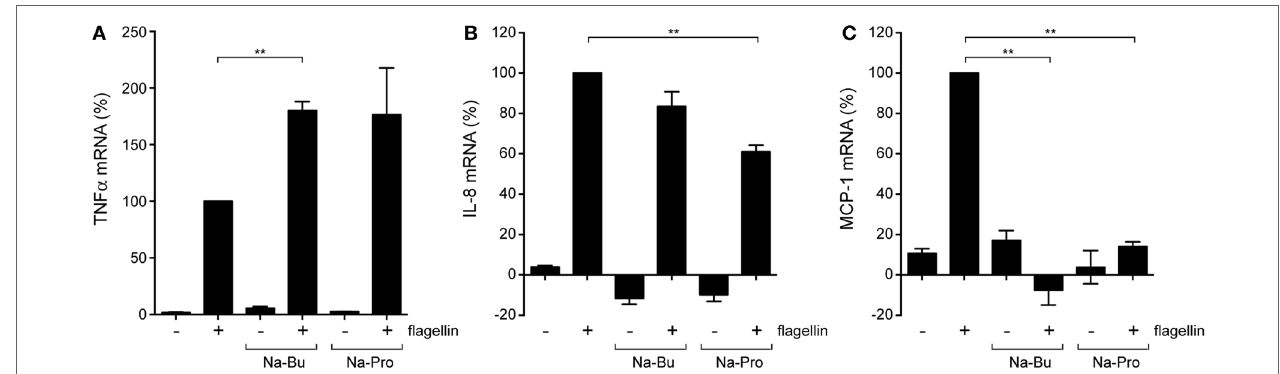
FigUre 3 | Modulation of cytokine expression by scFas. Quantitative RT-PCR of colonic epithelial HT-29 cells incubated with 10 mM Na-Butyrate or Na-Propionate for 30 min and stimulated with flagellin for 5 h. (a) mRNA levels of the pro-inflammatory cytokine TNF α . (B) mRNA levels of neutrophil chemotactic factor (IL-8). (c) mRNA levels of monocyte chemotactic protein 1 (MCP-1). Bars depict mean and SEM of three independent experiments. p < 0.05 (*), p < 0.01 (**), p < 0.005